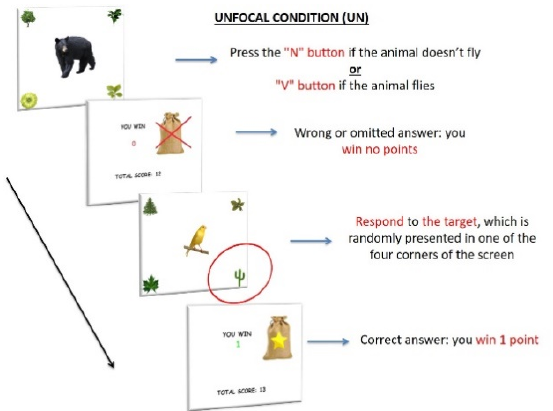
Figure 4. Procedure of Unfocal condition (UN). The items consisted of 120 images of an animal located at the center of the screen; images of plants were located at the four corners of the screen. As in the BC, participants had to press the “N” button when the image of a non-flying animal appeared on the screen and the “V” button when the image of a flying animal appeared on the center of the screen (ongoing task). However, when the cactus plant—Prospective target—appeared in one of the four corners of the screen (12 trials), participants were required to press the spacebar (PM task), instead of the semantic decision task. Each stimulus appeared for 2 s. They received 1 RP for every correct answer and no RP for any wrong or omitted answer, in both tasks (ongoing and PM trials).